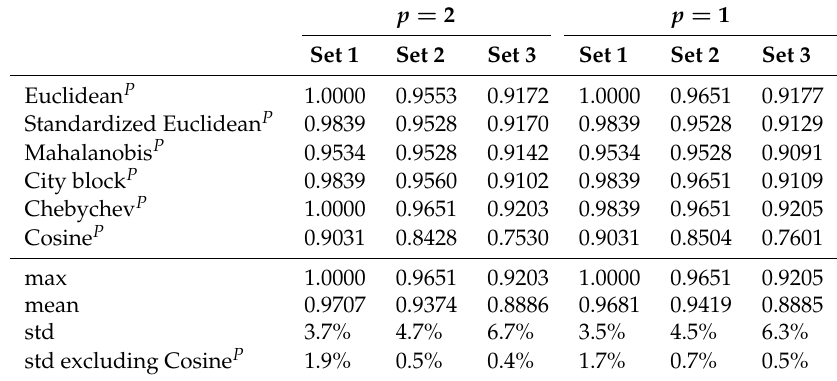
Table 2. Normalized mutual information (NMI) values for 6 × 2 = 12 different affinity propagation distances.